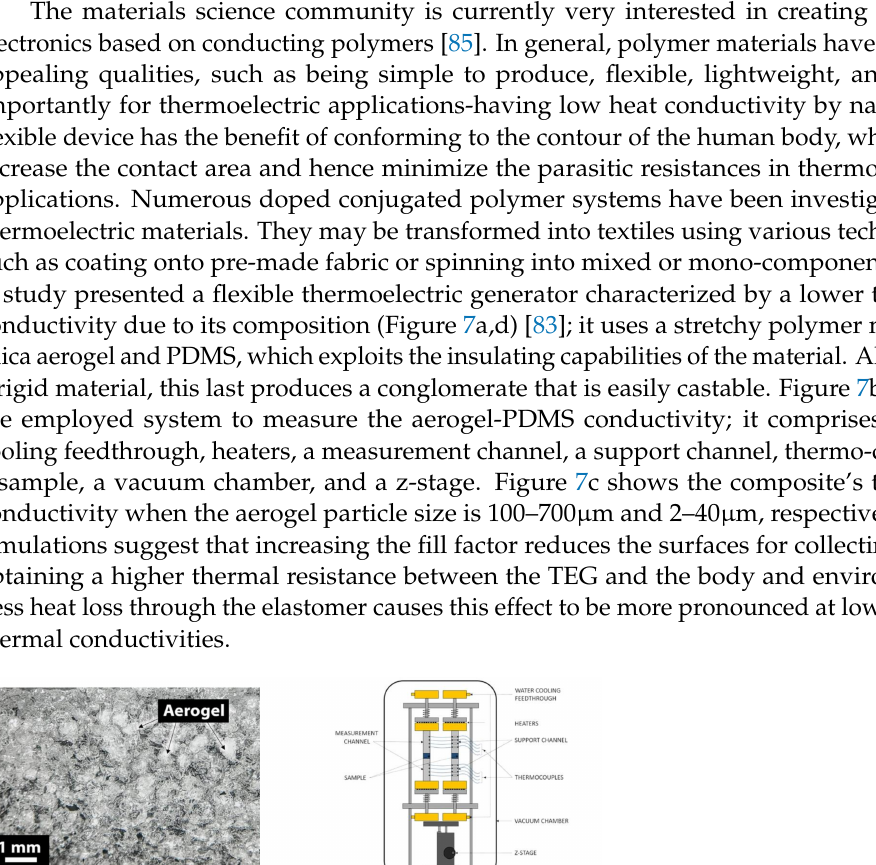
Figure 6. Flexible TEG module constituted by three key parts: EGaIn interconnects, Aerogel-Silicone filler, and high thermal conductivity encapsulation ( a ); two fingers deform a module ( b ) [83].